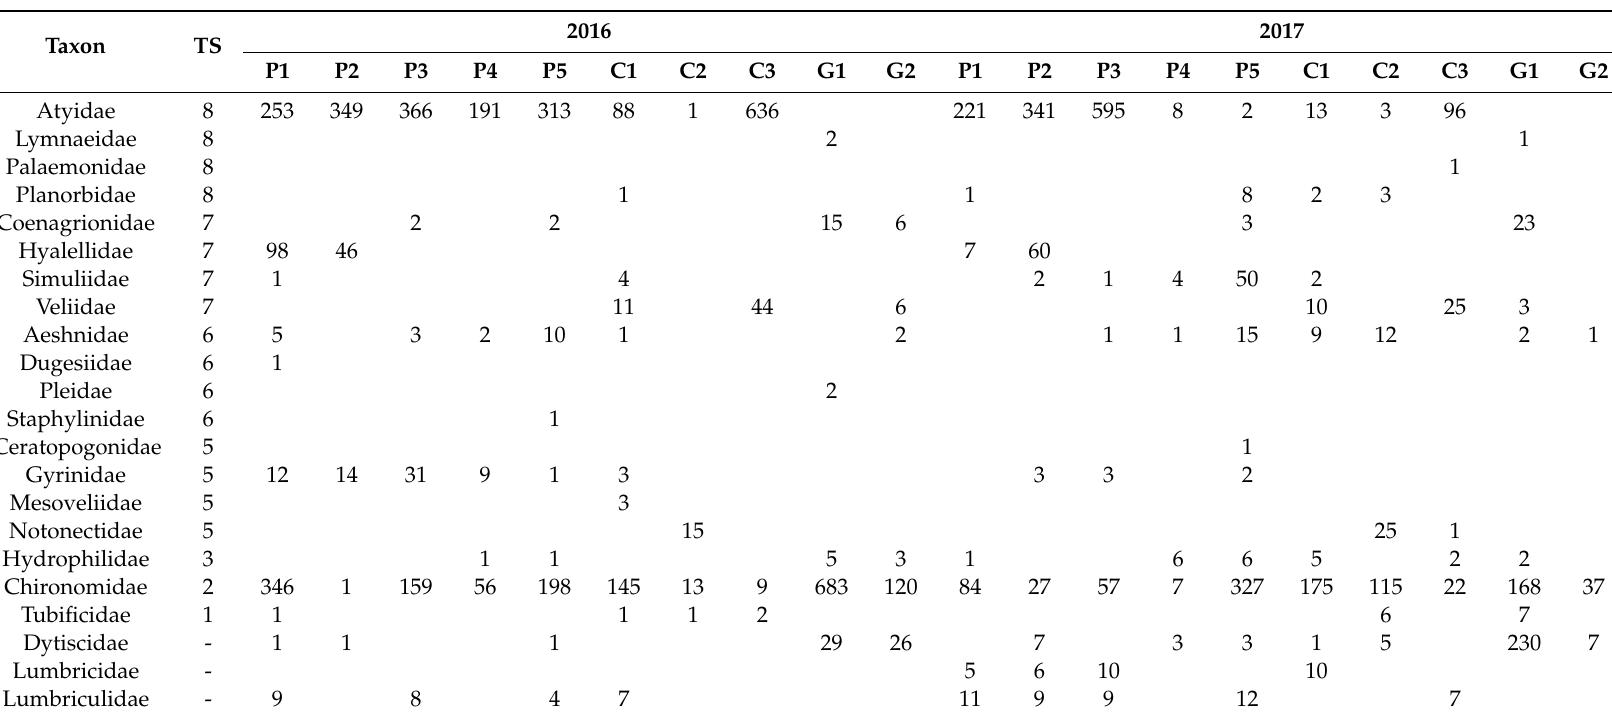
Table A2. List of macroinvertebrate taxa, their tolerance score, and abundance at each of the 10 locations sampled in 2016 and 2017. Tolerance scores (TS) were based on Rold á n [31] and Á lvarez Arango